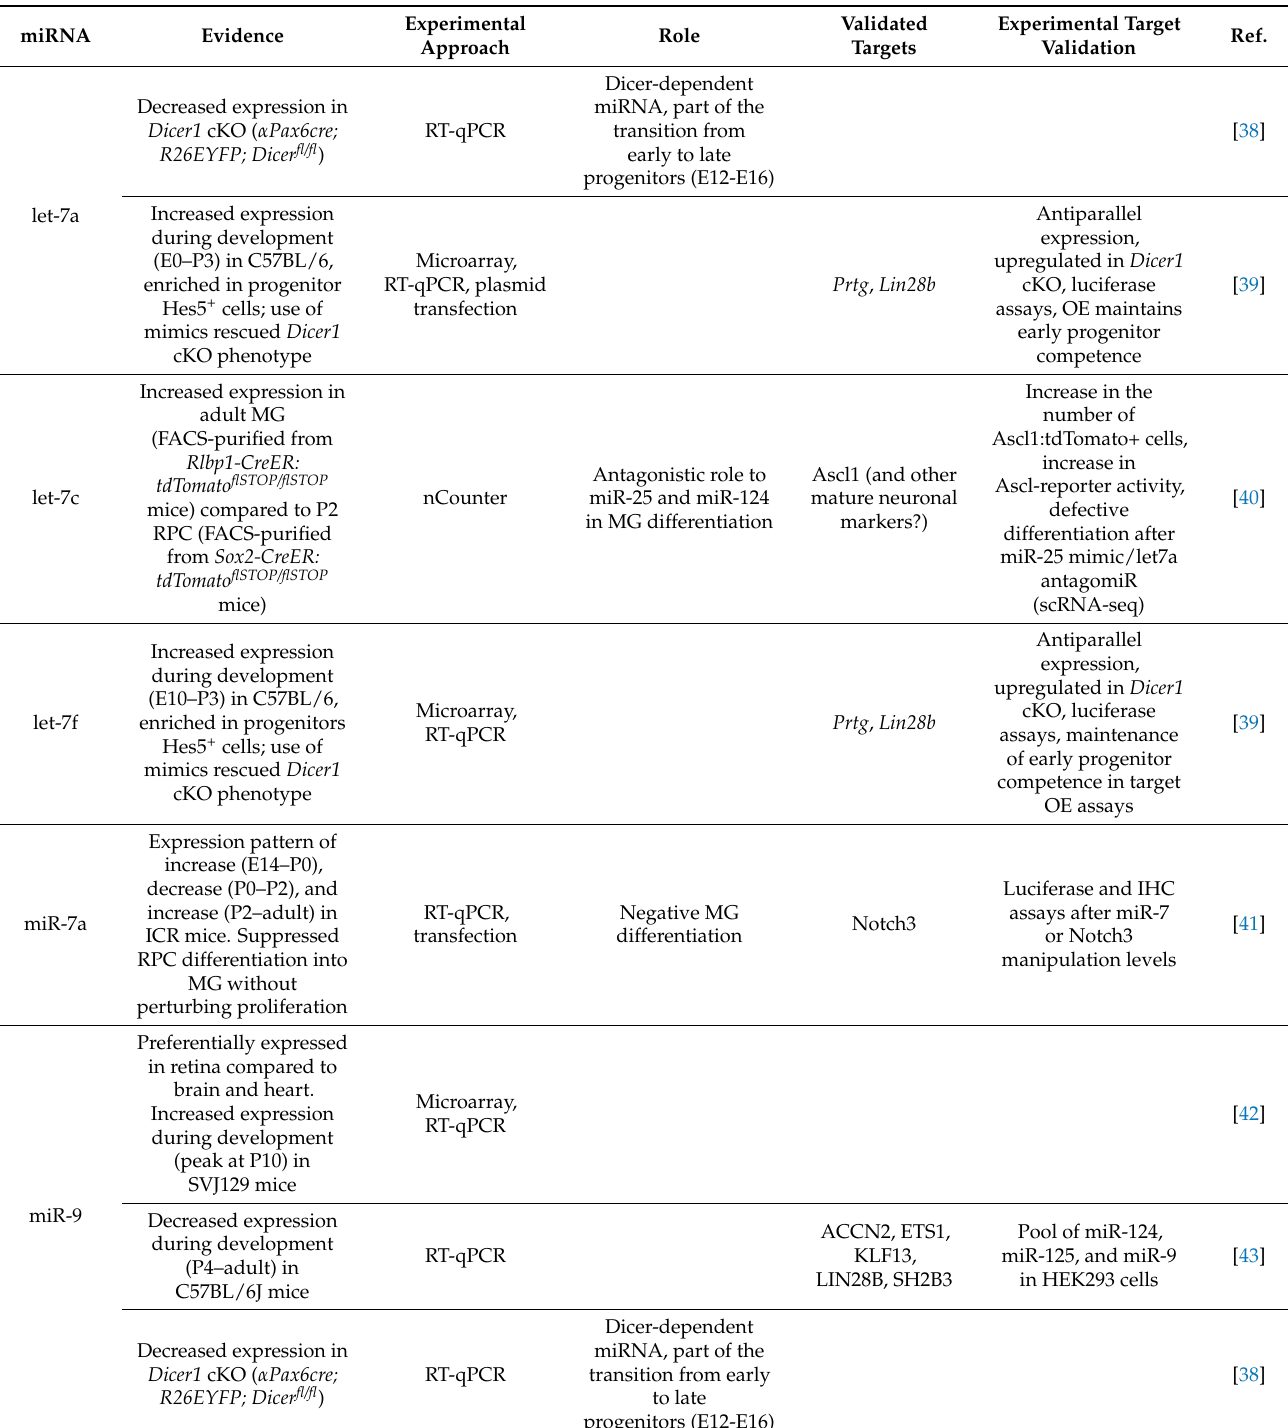
Table 1. Summary of the most relevant results and experimental evidence regarding miRNAs in mouse retinal development. EC, endothelial cells; ERG, electroretinogram; FACS, fluorescent acti- vated cell sorting; HRMEC, human retinal microvascular endothelial cells; ISH, in situ hybridization; MG, Müller glia; OCT, optical coherence tomography; OE, over-expression; OIR, oxygen-induced retinopathy; PAR-CLIP, photoactivatable ribonucleoside-enhanced crosslinking and immunoprecipi-